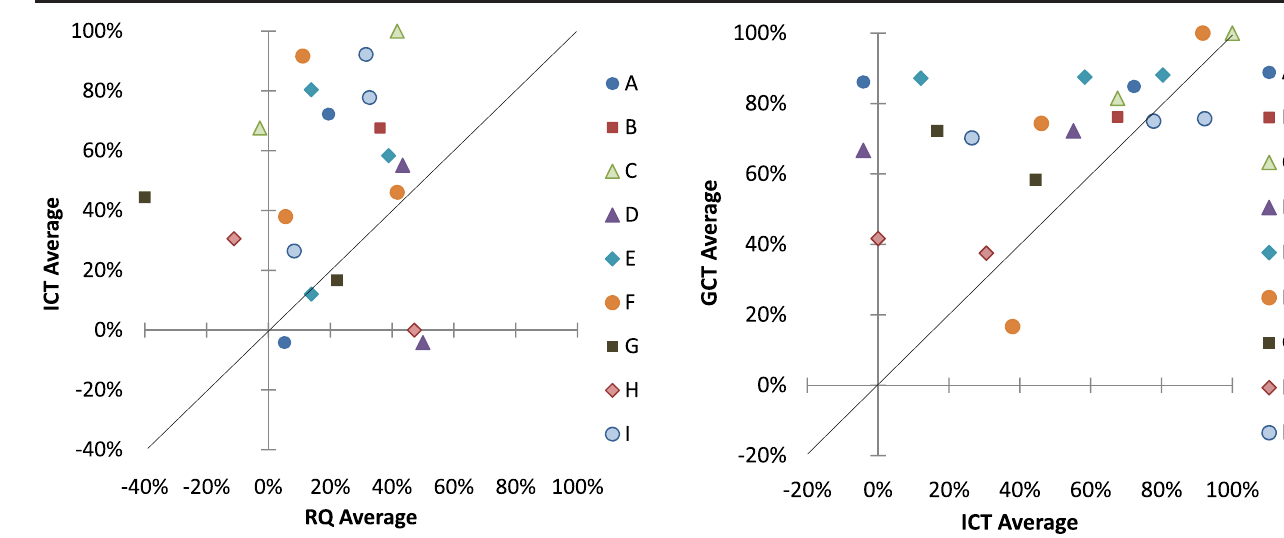
FIG. 2. Student performance on GCT vs ICT, averaged across all comparison questions ( p ¼ 0 . 009 ). Error bars are not shown on the plot for clarity; the average standard error was (cid:2) 8% for the ICT and (cid:2) 5% for the